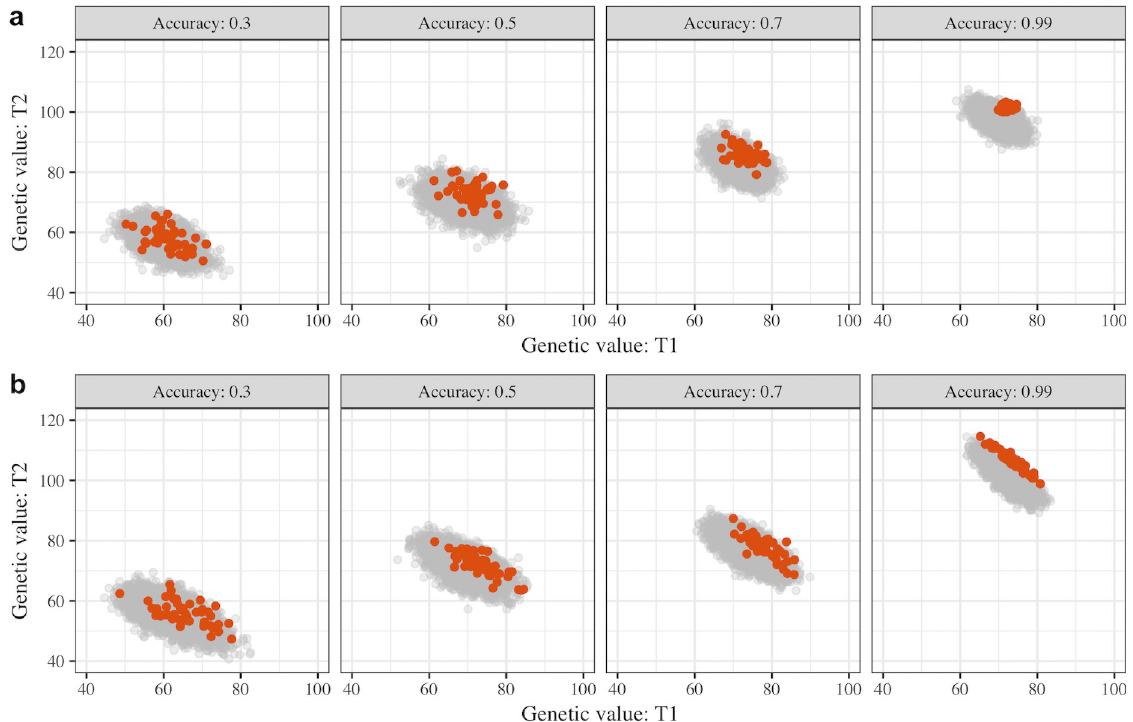
Fig 1. Scatterplots of true genetic values for Trait 1 (T1) and Trait 2 (T2) of the genotypes in the F1 population (grey) and genotypes selected as parents (orange) in the third cycle of selection using either independent culling (a) or a selection index (b) with different levels of accuracy.